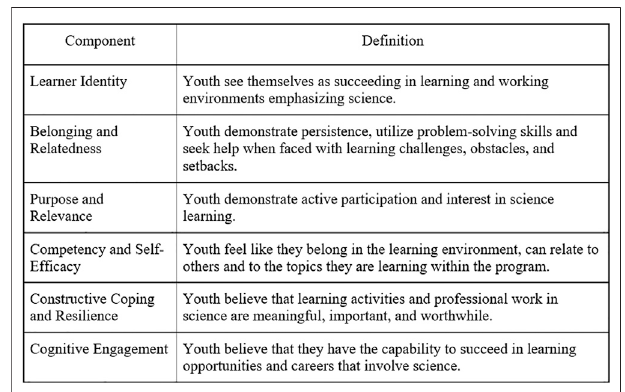
FIGURE 1 | De fi nitions of each STEM component used in the pre- and post-survey.